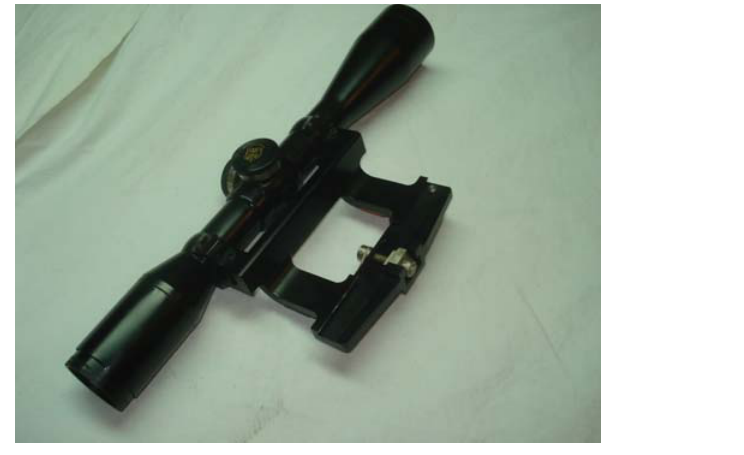
Figure 6 – ON 8 x 56m optical sight (Teleoptik-Gyros, 2018b) Рис . 6 – Оптический прицел ОН 8 x 56 м (Teleoptik-Gyros, 2018b)